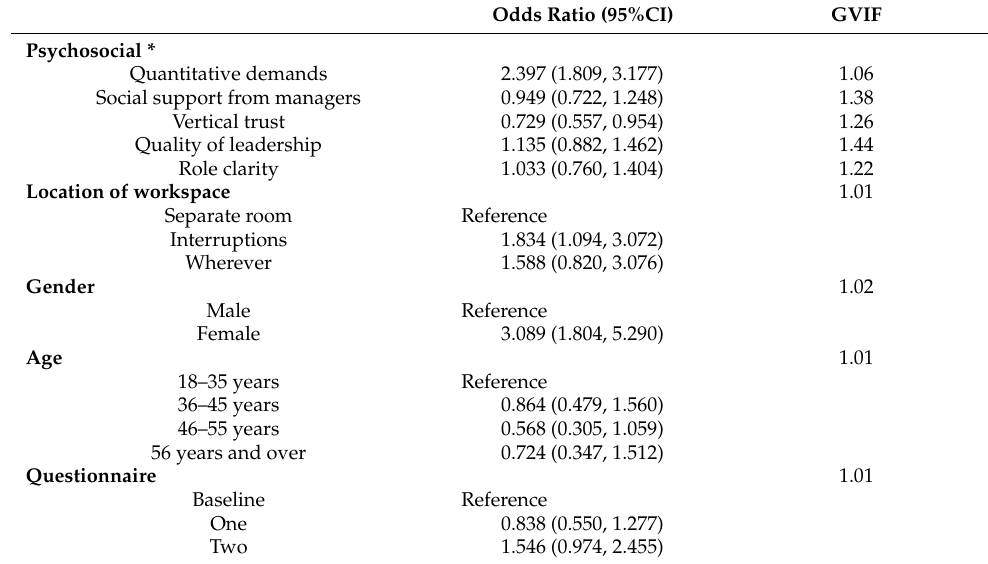
Table 3. Associations between musculoskeletal pain and psychosocial factors and workspace.